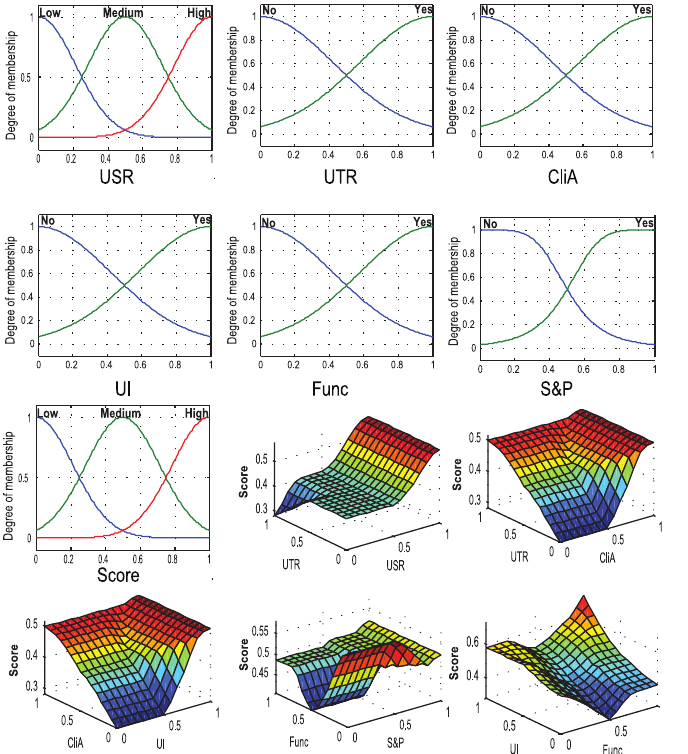
Fig 8. Input membership and relation between the input-output in the rule base